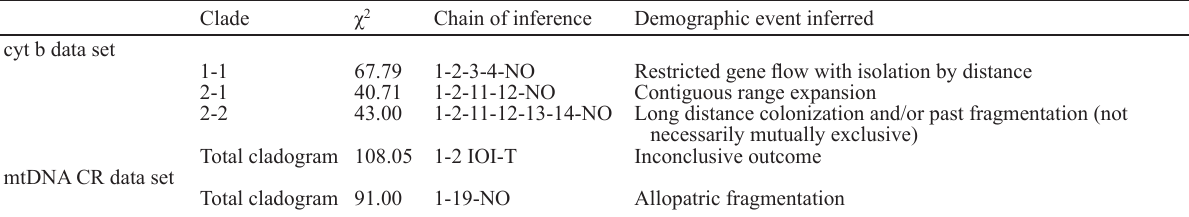
Table 3. – Interpretation of the results of the nested clade analysis of cyt b and mtDNA CR sequences of eastern Adriatic populations, based on the inference key of Templeton (2005). Only clades with significant chi-square statistics ( χ 2 ) are included.